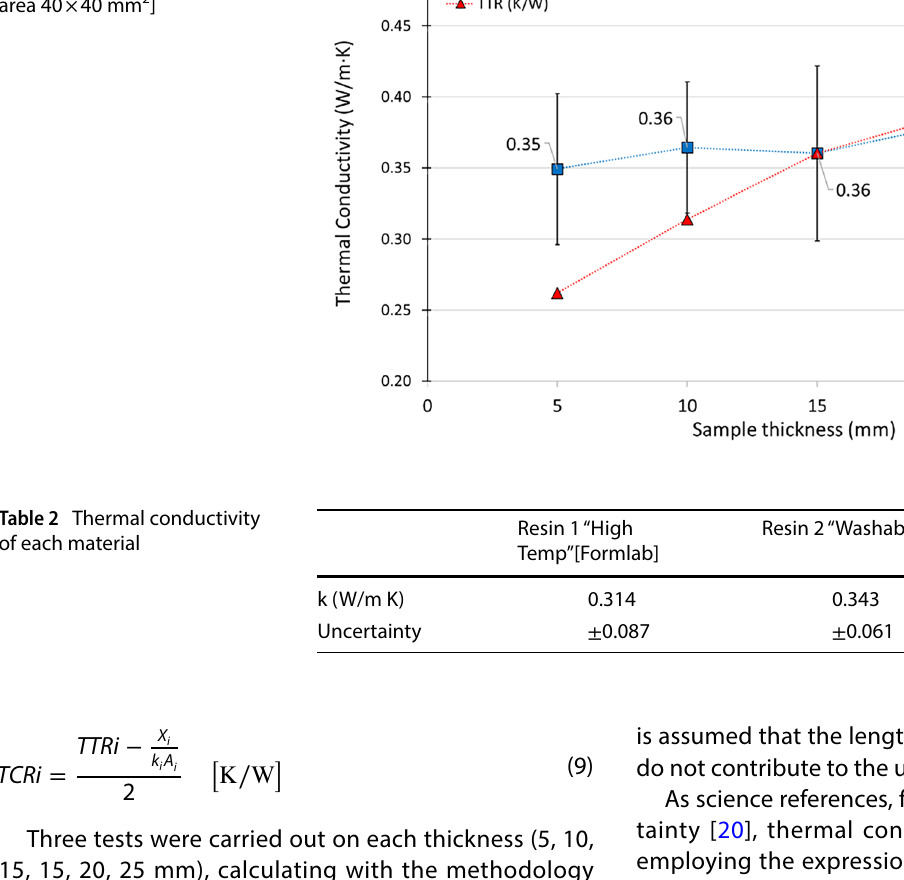
Fig. 8 Study result. Resin Type 3- STANDARD [sample contact